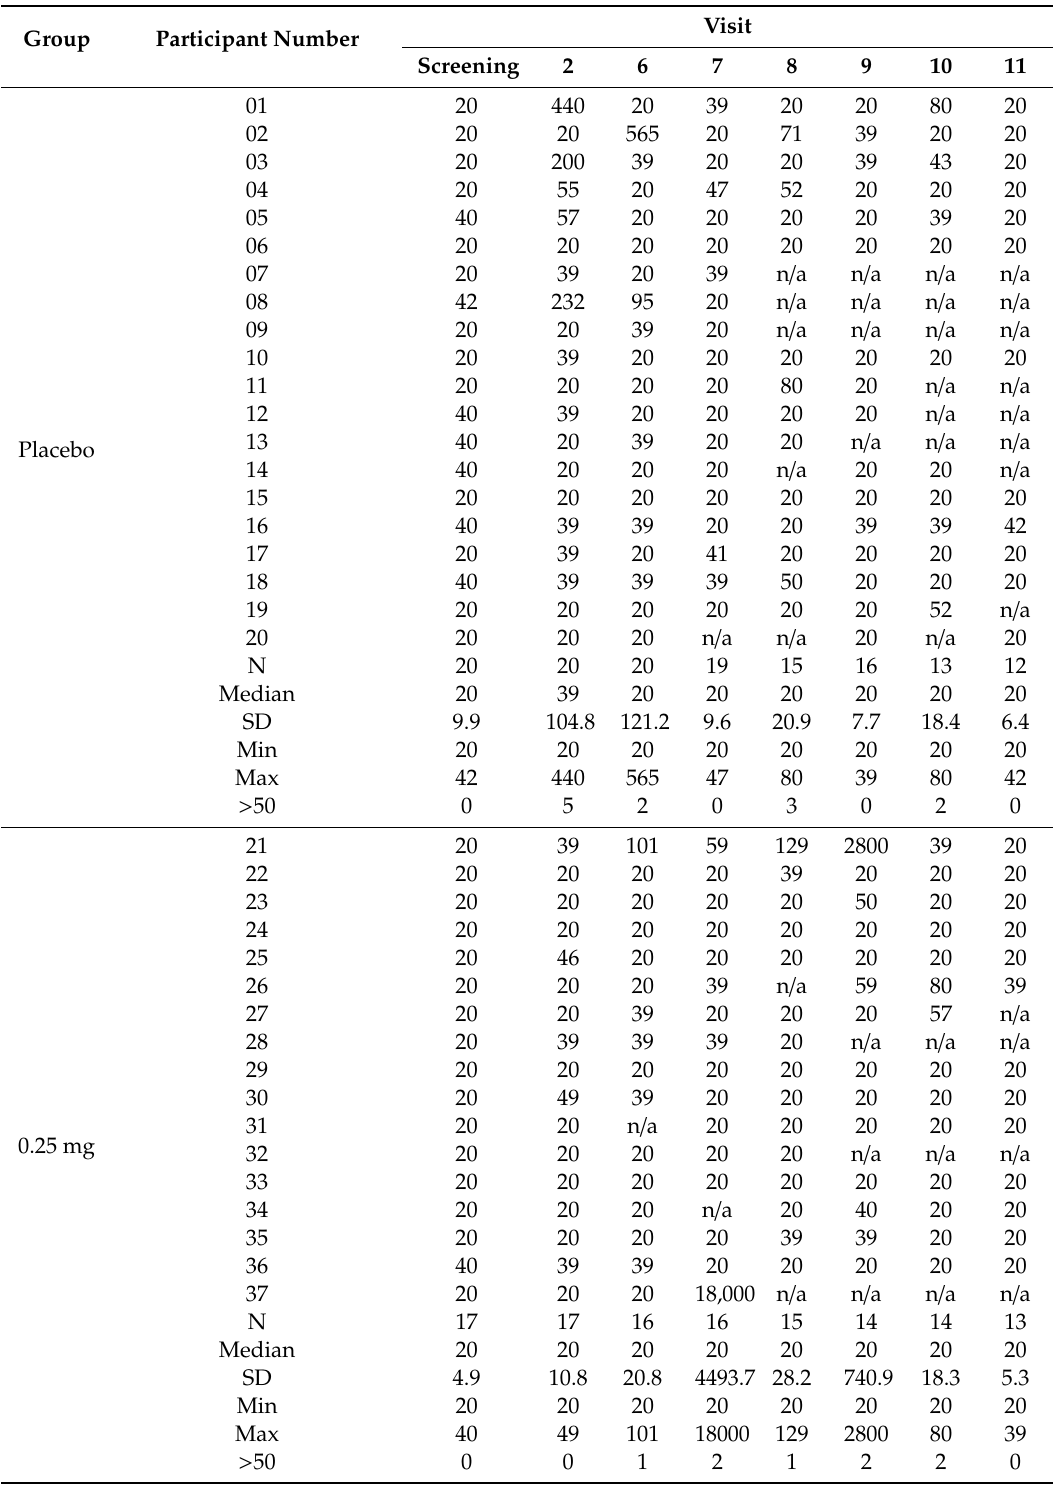
Table A1. Data on viral load measured in trial